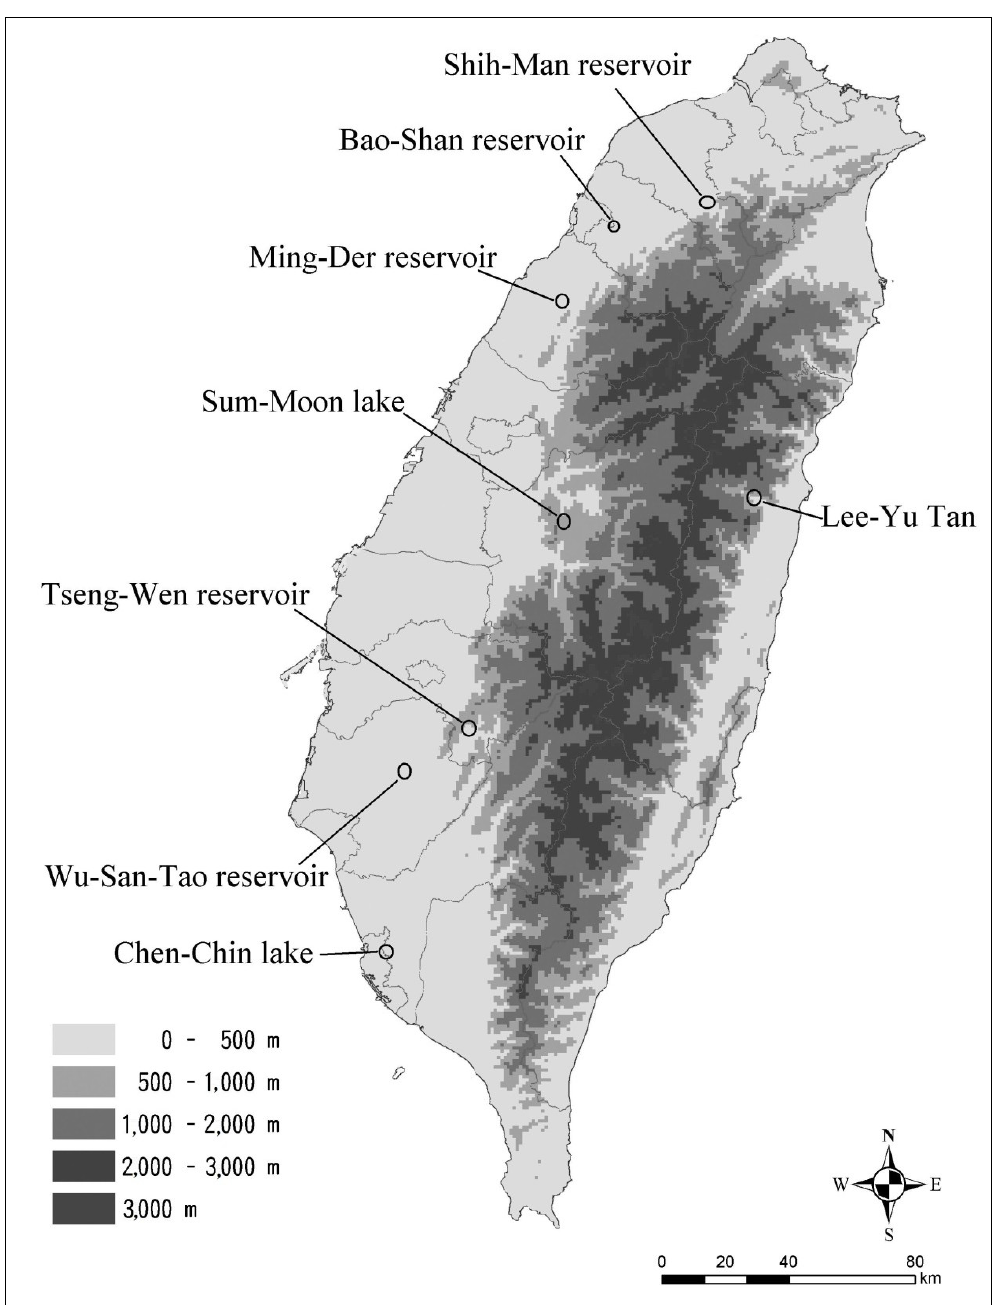
Figure 1. Distribution of sampling sites: each site was separated by different river